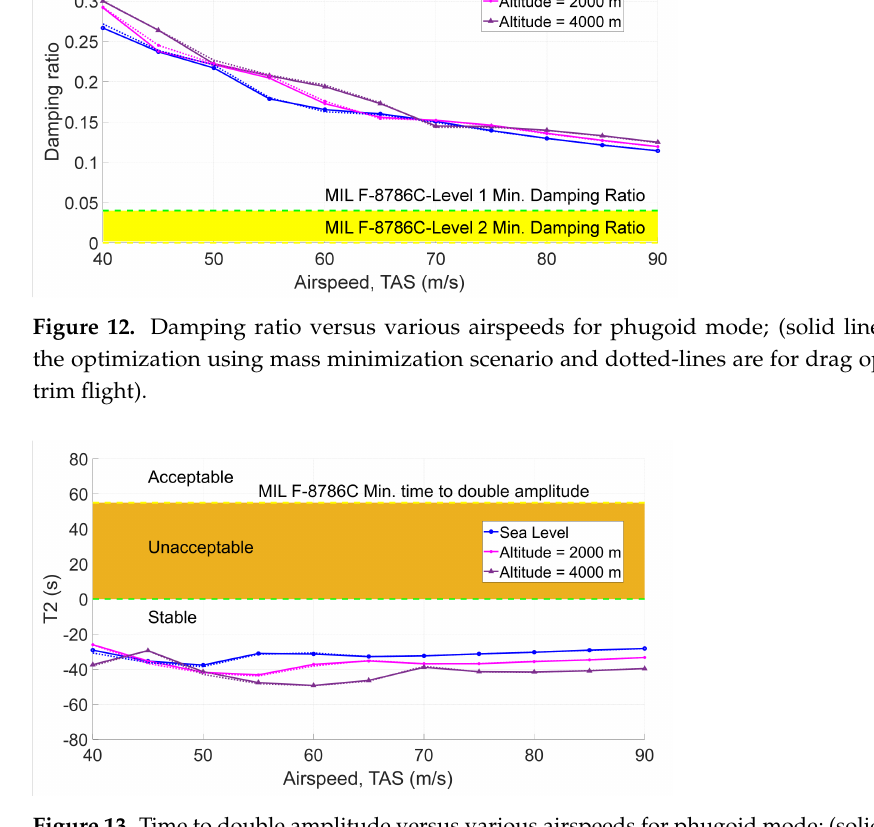
Figure 13. Time to double amplitude versus various airspeeds for phugoid mode; (solid lines account for the optimization using mass minimization scenario and dotted-lines are for drag optimization in trim flight).